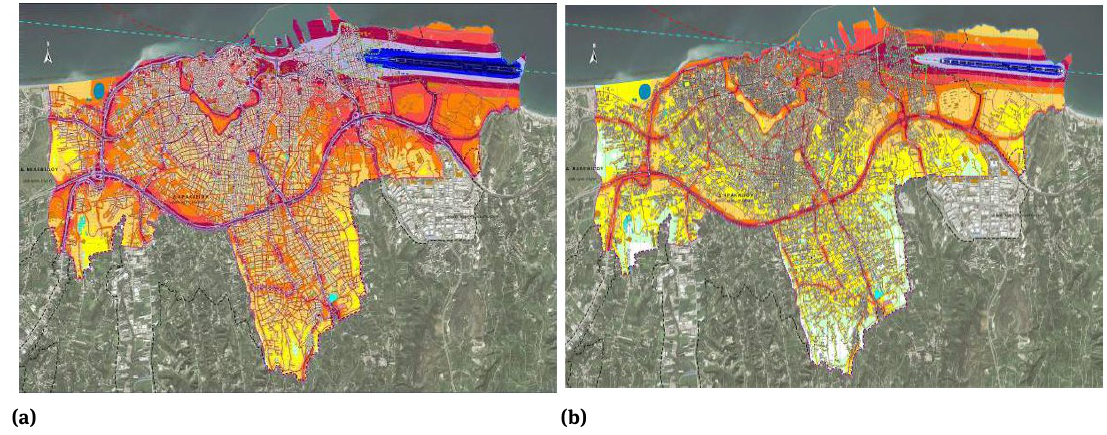
Fig. 4. Herakleion SNM 2012 – Noise indices (a) L den & (b) L night